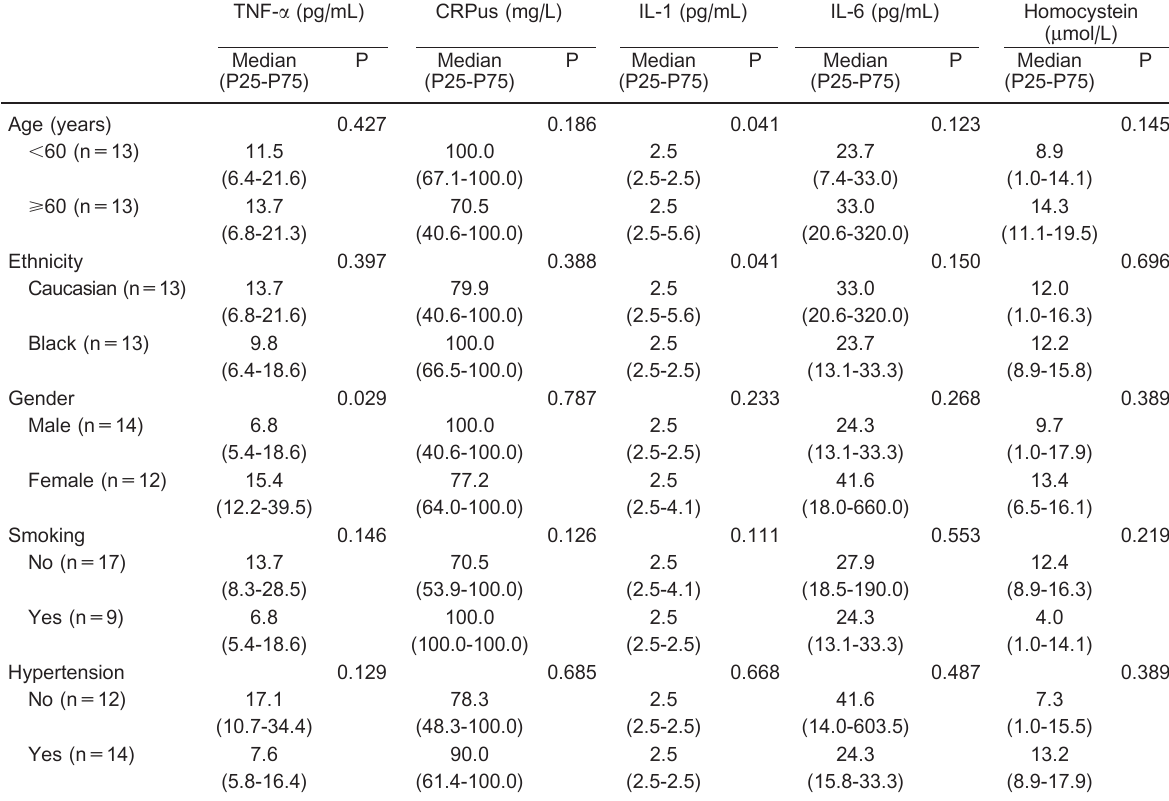
Table 2. TNF- a , CRPus, IL-1, IL-6, and homocystein levels in serum according to the demographic and clinical patient